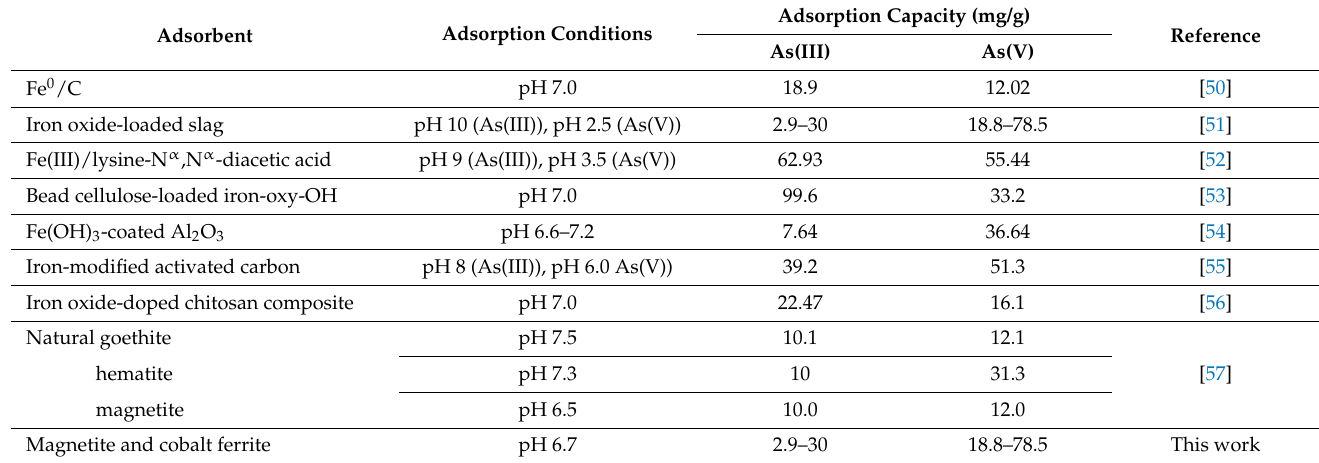
Table 3. Comparison of adsorption capacity toward As(III, V) with some magnetic adsorbents.